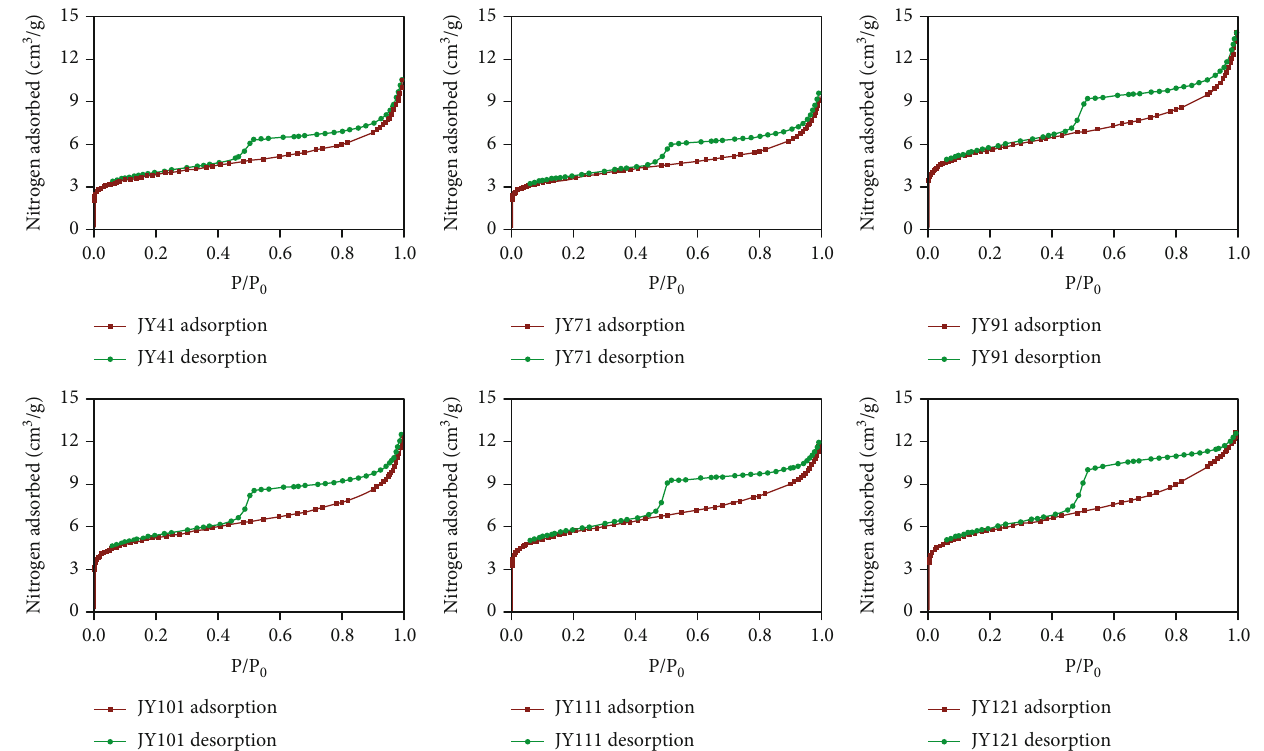
Figure 1: The nitrogen adsorption-desorption isotherms of the studied gas shales.